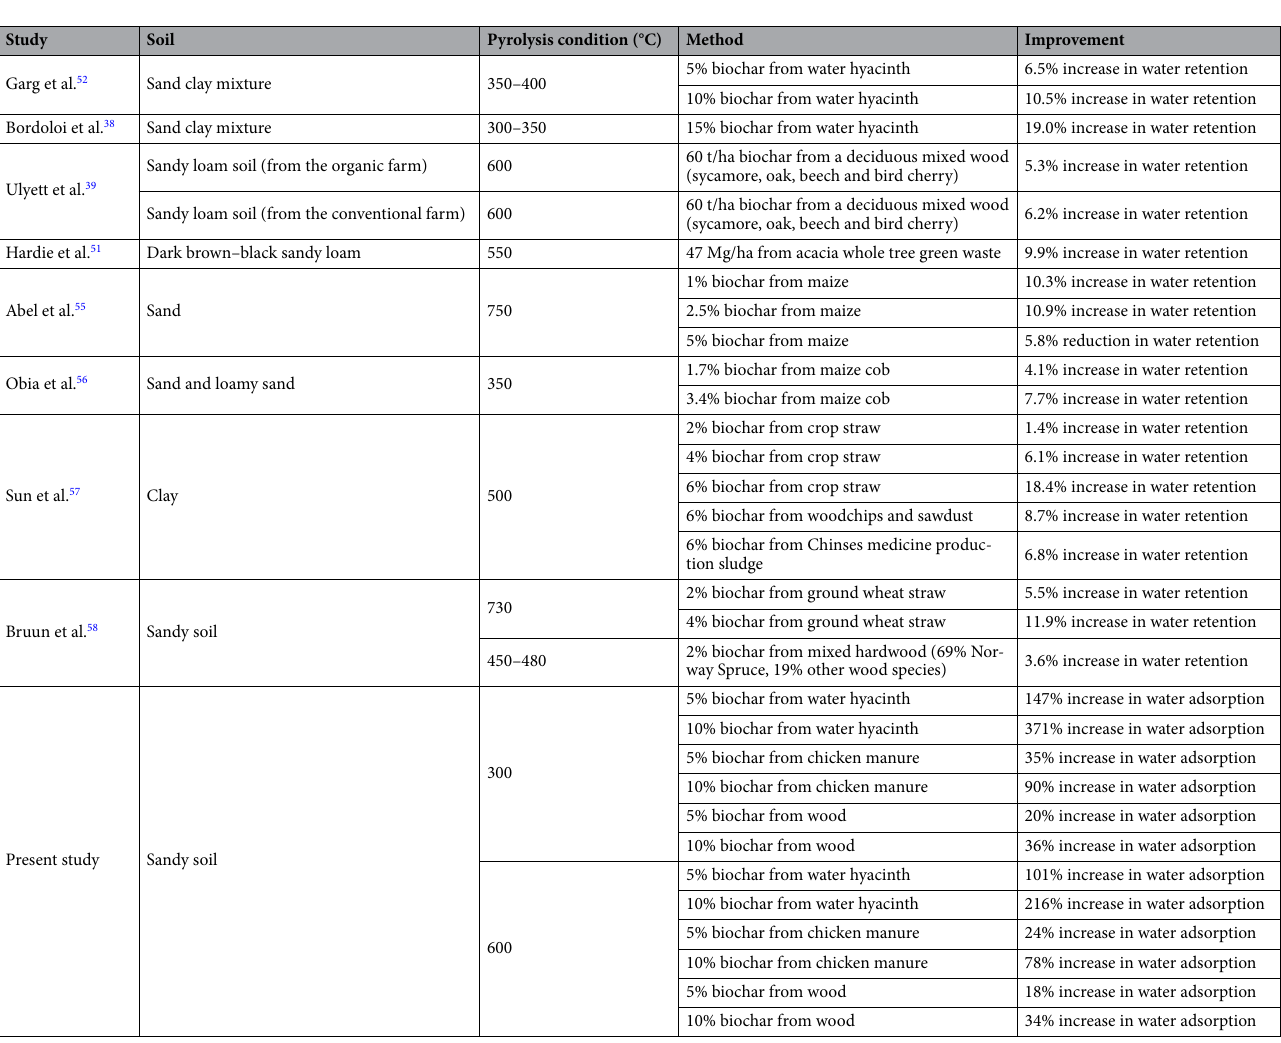
Table 7. The performance of biochar in water